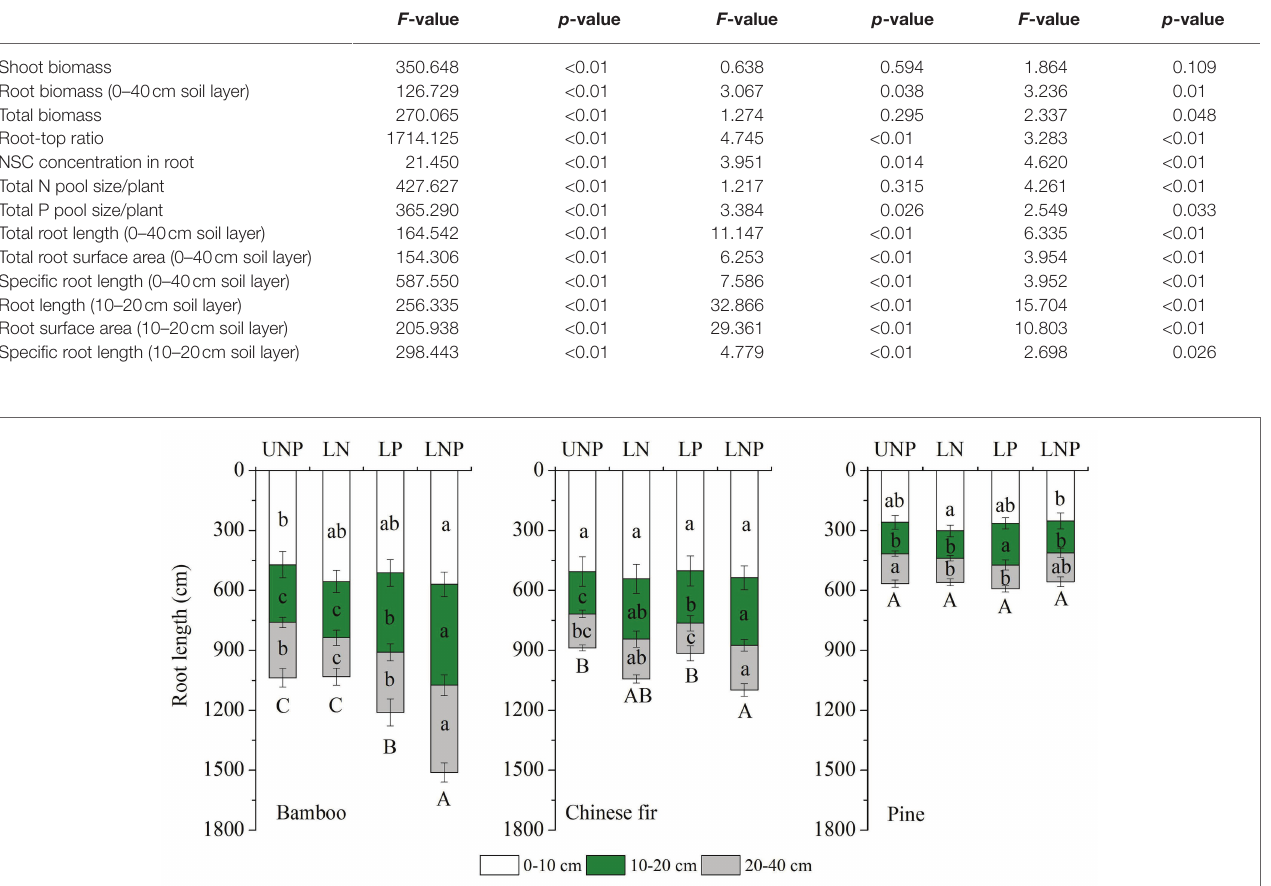
TABLE 2 | Effects of species, nutrient treatments, and their interactions on whole plant and root parameters. Species Treatment Species × Treatment Parameter F -value p -value F -value p -value F -value Shoot biomass